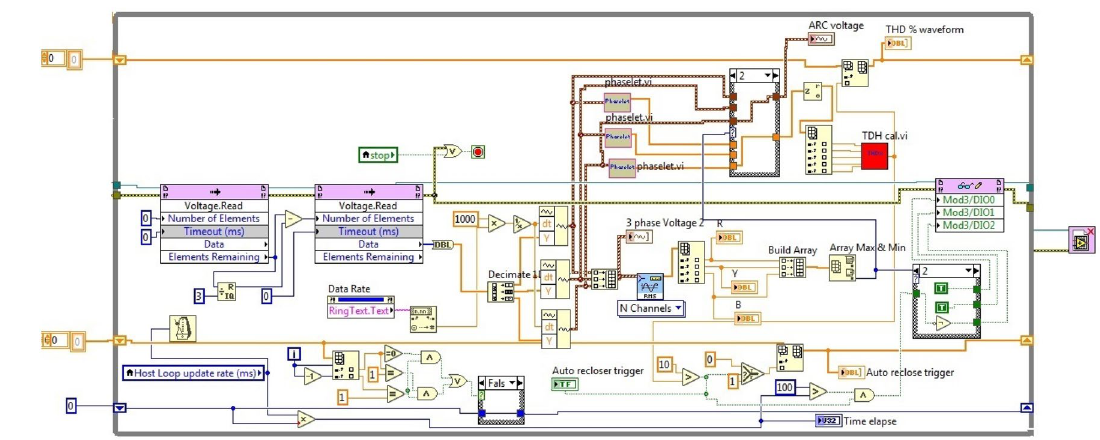
Fig. 10 LabVIEW program for